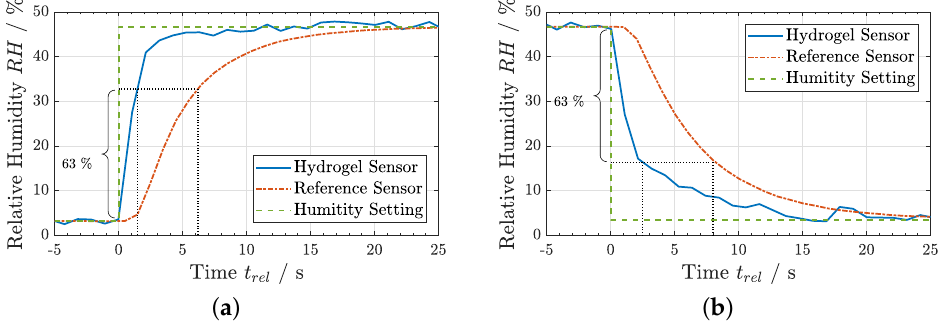
Figure 7. Time response of RH measured with the hydrogel sensor compared to a commercial reference sensor after an abrupt change of the humidity setting for: ( a ) a humidity rise; and ( b ) a humidity drop. The dotted lines indicate the response time parameter τ 63